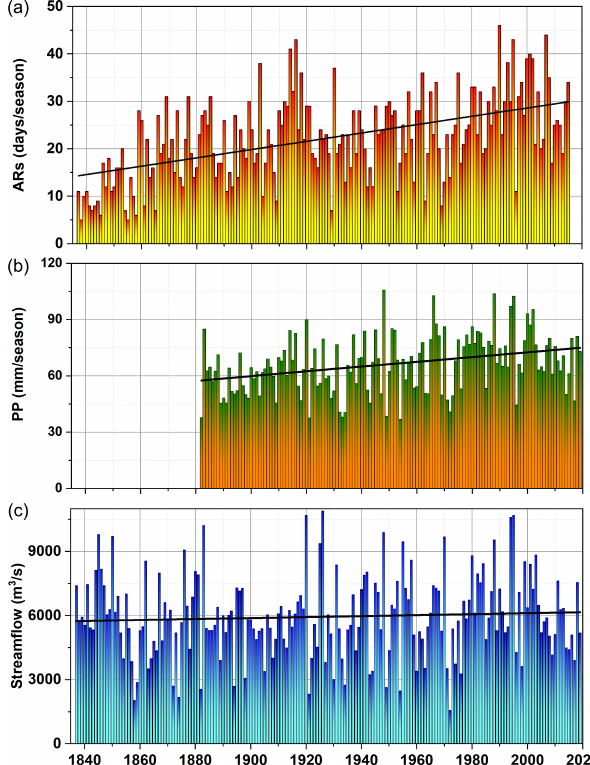
Figure 13. (a) Number of days per season with ARs over the region (4–12 ◦ E, 47–56 ◦ N) for the period 1836–2015. (b) Seasonal pre- cipitation averaged over the German side of the Rhine catchment area for the period 1881–2019. (c) Daily maximum streamflow at the Köln gauging station over the period 1836–2019. For panels (a– c) , we used only the period of November–March for the